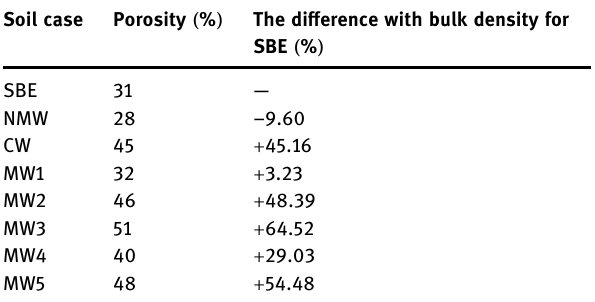
Figure 4: The porosity of the